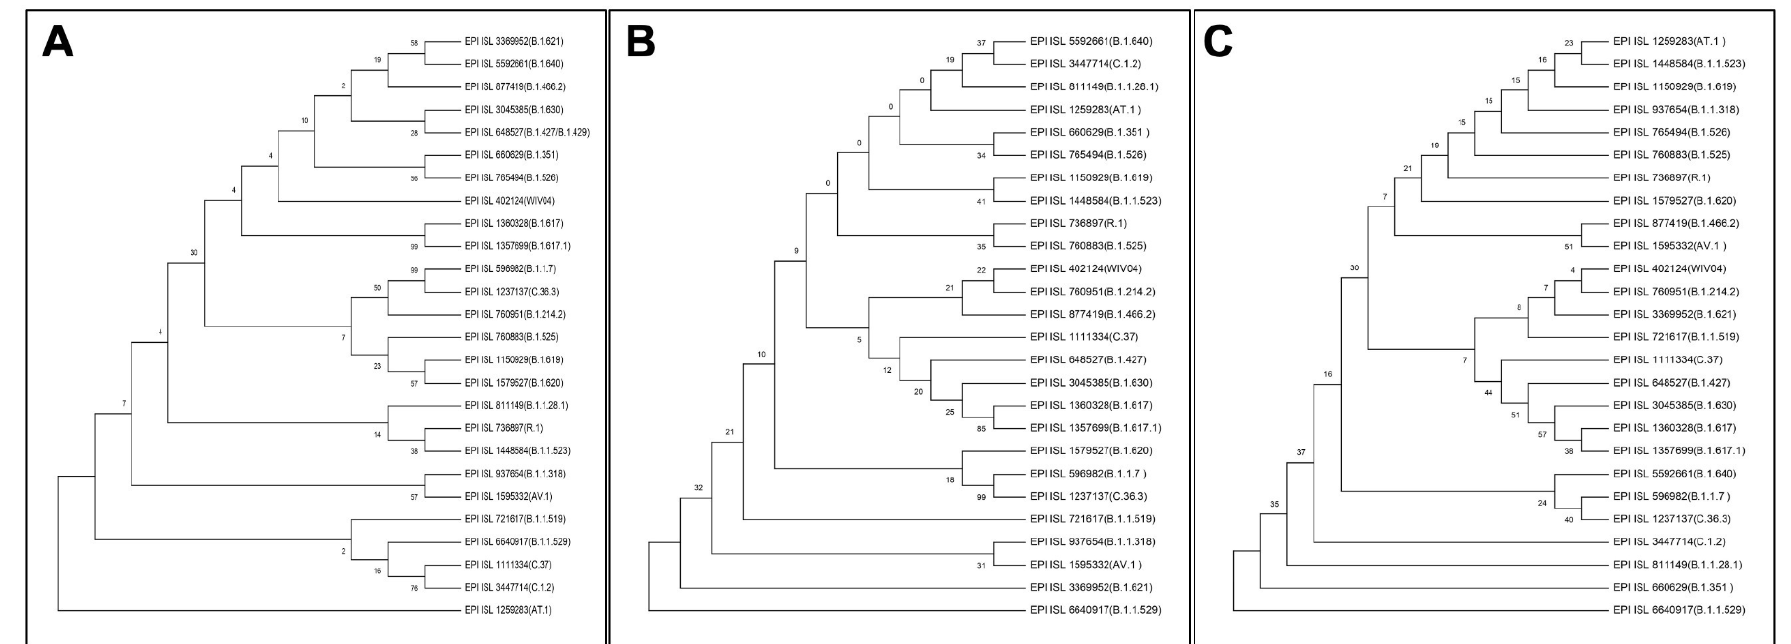
Figure 4: Phylogenetic tree of SARS-CoV-2 variants constructed using ( A ) whole genome, ( B ) S protein, and ( C )